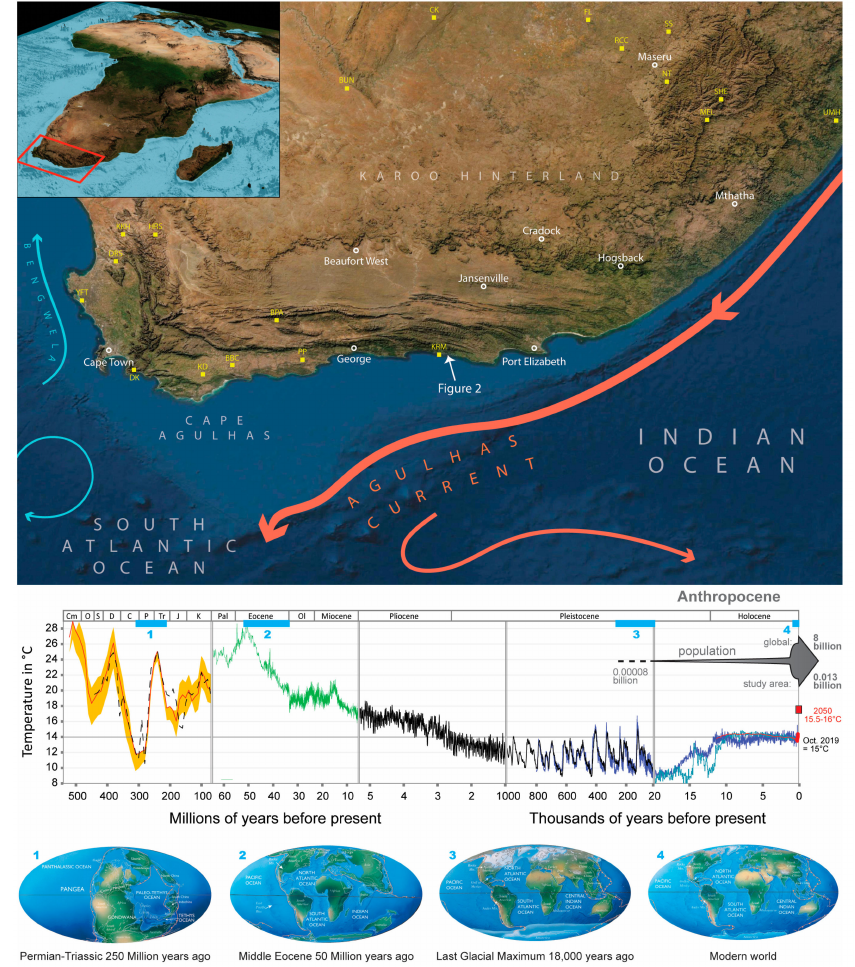
Figure 1. Map of southernmost Africa (inset for location), a unique ‘Cape-Karoo’ region flanking